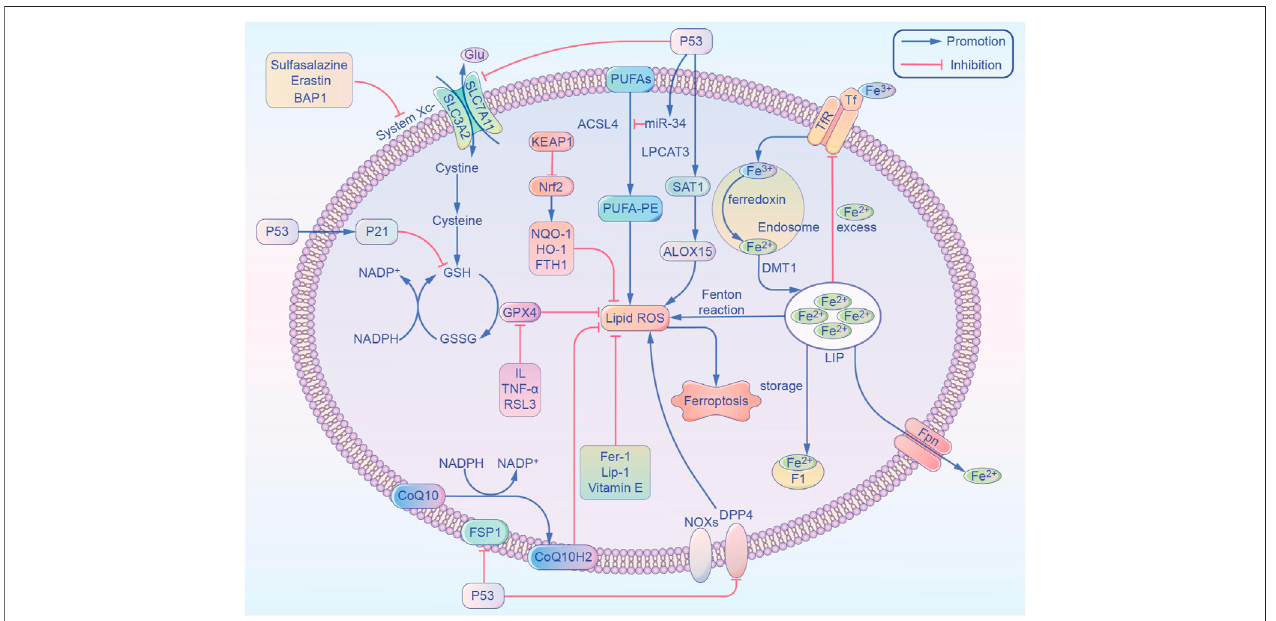
FIGURE1| Overview ofthe metabolic routes contributing toferroptosis. Thisnon-exhaustivelist includes (1) iron-Fenton reaction. (2)GPX4 antioxidantactivity. (3) Lipid metabolism pathway. ACSL4, acyl-coenzyme A synthetase long chain family member 4; ALOX15, arachidonate 15-lipoxygenase; BAP1, BRCA1 associated protein 1; CoQ10, coenzyme Q10; CoQ10 H2, ubiquinol; DPP4, dipeptidyl-peptidase-4; DMT1, divalent metal transporter 1; FTH1, ferritin heavy chain 1; Fer-1, ferrostatin-1; FSP1, ferroptosis suppressor protein 1; Fpn, ferroportin; GPX4, glutathione peroxidase 4; GSH, glutathione; GSSG, oxidized glutathione; Glu, glutamic acid; HO-1, heme oxygenase-1; IL, interleukin; Lip-1, liproxstatin-1; LPCAT3, lysophosphatidylcholine acyltransferase 3; LIP, labile iron pool; NADPH, nicotinamide adenine dinucleotide phosphate; Nrf2, nuclear factor E2 related factor 2; NOX1, NADPH Oxidase 1; NQO-1, NAD(P)H quinone dehydrogenase 1; PUFAs, polyunsaturated fatty acids; ROS, reactive oxygen species; SAT1, spermidine/spermine N1-acetyltransferase 1; System Xc-, glutamate-cystine/antiporter; SLC7A11, solute carrier family 7 member 11; SLC3A2, solute carrier family 3 member 2; TNF- α , tumor necrosis factor- α ; TfR, transferrin receptor; Tf, transferrin.